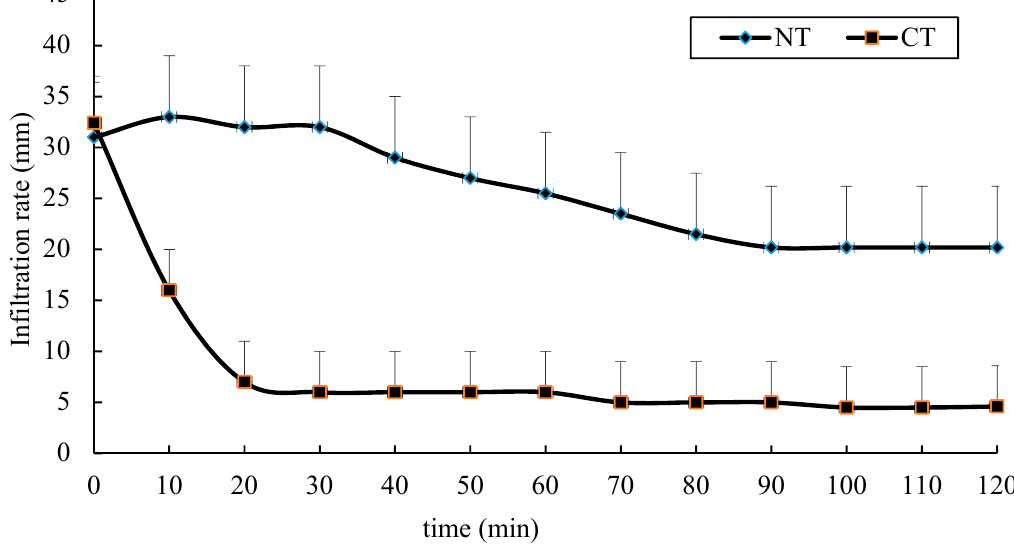
Figure 2. Changes in soil infiltration rate within 120 min under no tillage (NT) and conventional tillage (CT) treatments. LSD ( p < 0.05). Redrawn from He et al. [32].